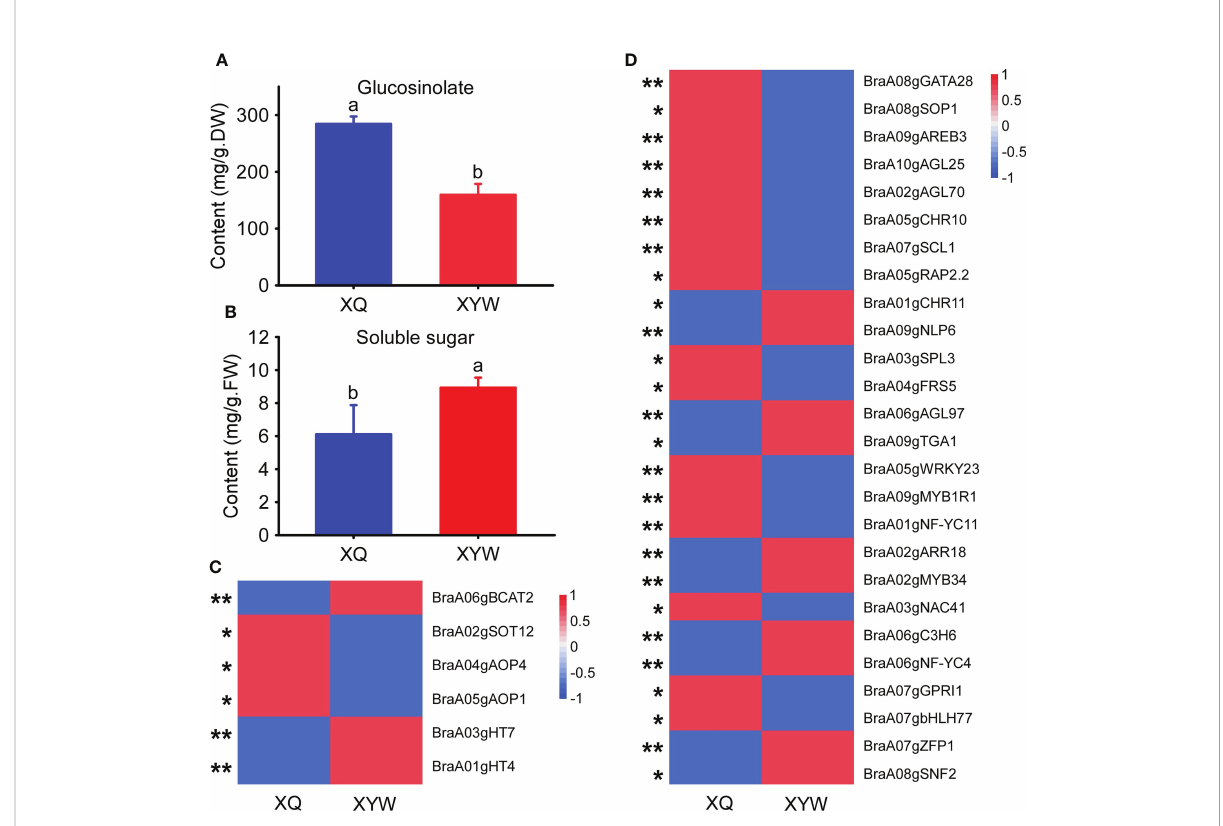
FIGURE 7 Expression analysis of key genes related to soluble sugar and glucosinolate biosynthesis in yellow and white inner-leaf Chinese cabbage. (A) Glucosinolate content at the seedling stage. (B) Soluble sugar content at the seedling stage. Data are means ± SD, N = 3. Lowercase letters indicate that there are signi fi cant differences between ‘ XQ ’ and ‘ XYW ’ (P ≤ 0.05). (C) Relative expression of structural genes involved in glucosinolate and soluble sugar biosynthesis at the seedling stage. (D) The expression of transcription factors involved in glucosinolate and soluble sugar biosynthesis at the seedling stage. Asterisks indicate statistical signi fi cance using Student ’ s t-test: *,P ≤ 0.05, **,P ≤